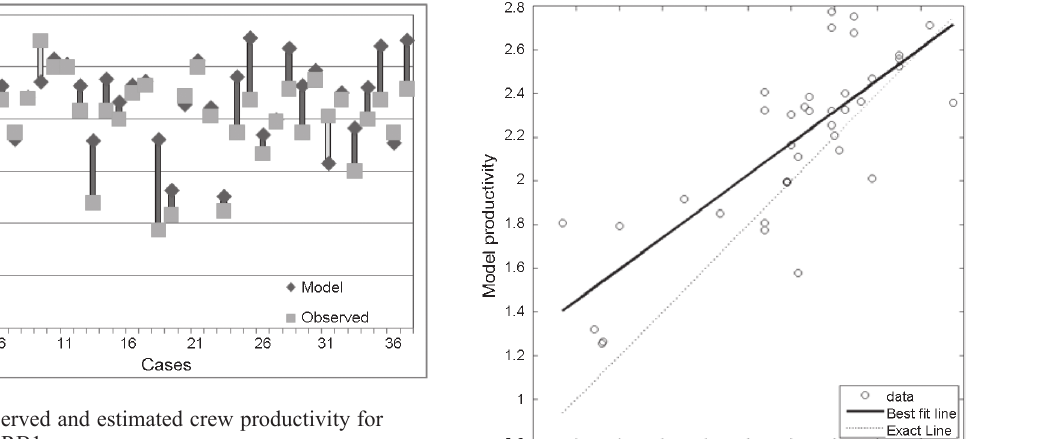
Fig. 5. The observed and estimated crew productivity for baseline model RB1